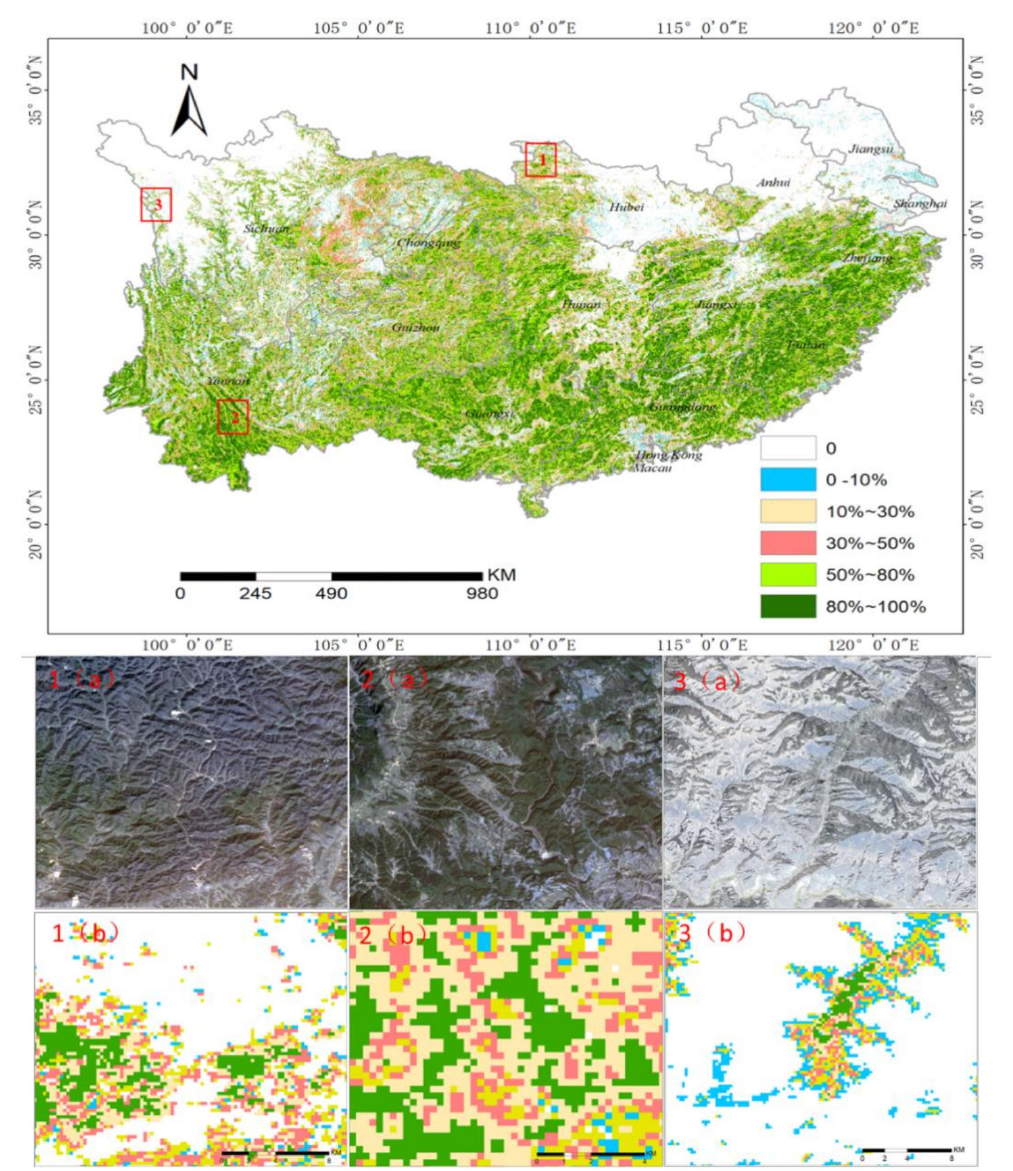
Figure 7. Evergreen forest cover in the study area. 1( a ), 2( a ), and 3( a ) are false-color composite images produced by combining GF-1 blue, green, and red bands obtained in winter (31 December 2017; 16 January 2018; and 2 February 2018) for areas corresponding to red boxes 1–3 on the map. 1( b ), 2( b ), and 3( b ) are magnifications of 1( a ), 2( a ), and 3( a ),